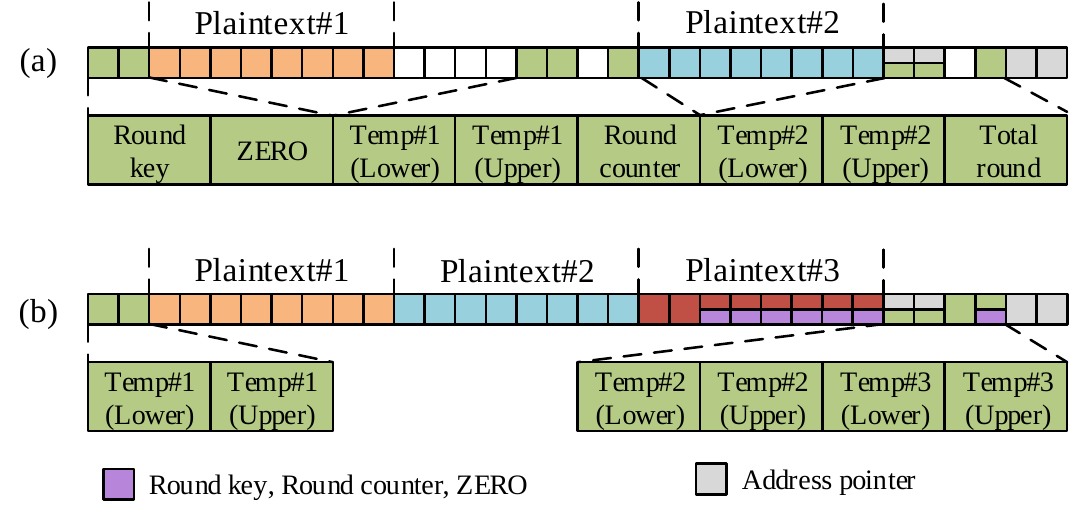
Figure 6. Register alignment for ( a ) 2-parallel and ( b ) 3-parallel of CHAM-64/128 implementations. Each block represents one register. Two color in one register is used for various purposes.